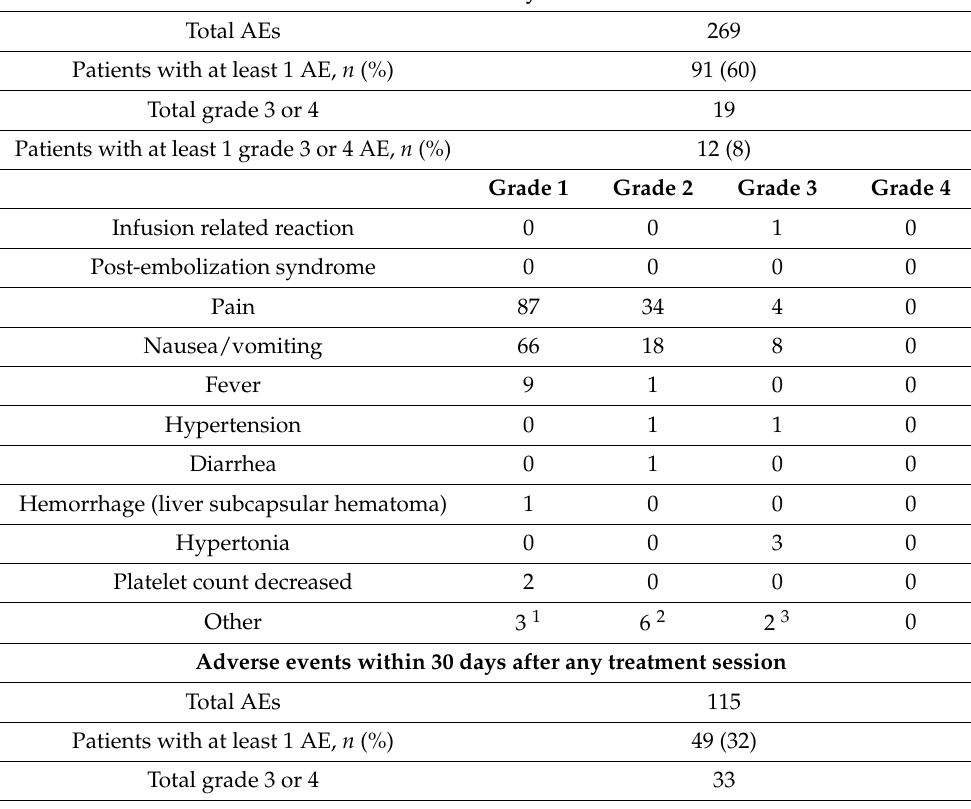
Table 2. AEs after LP-irinotecan-TACE treatment sessions graded according to CTCAE 4.3/5.0. Data is presented as counts and percentages. Adverse Events at the Same Day as a Treatment Session Total